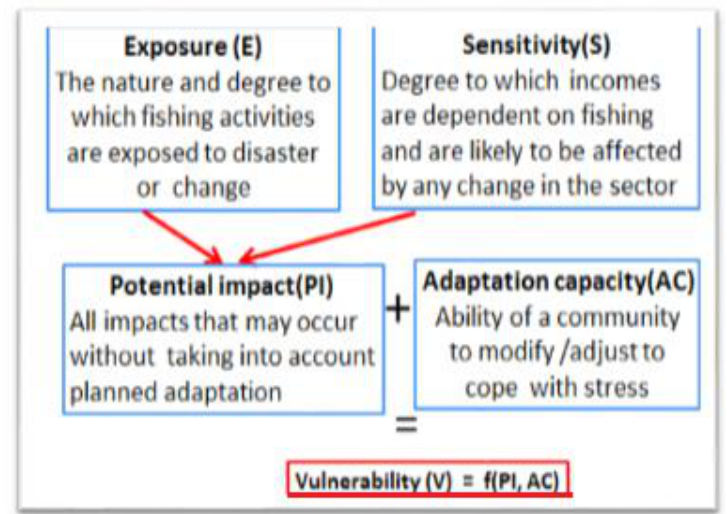
Fig. 1: Conceptual model of vulnerability of fishers; adapted from Allison et al .